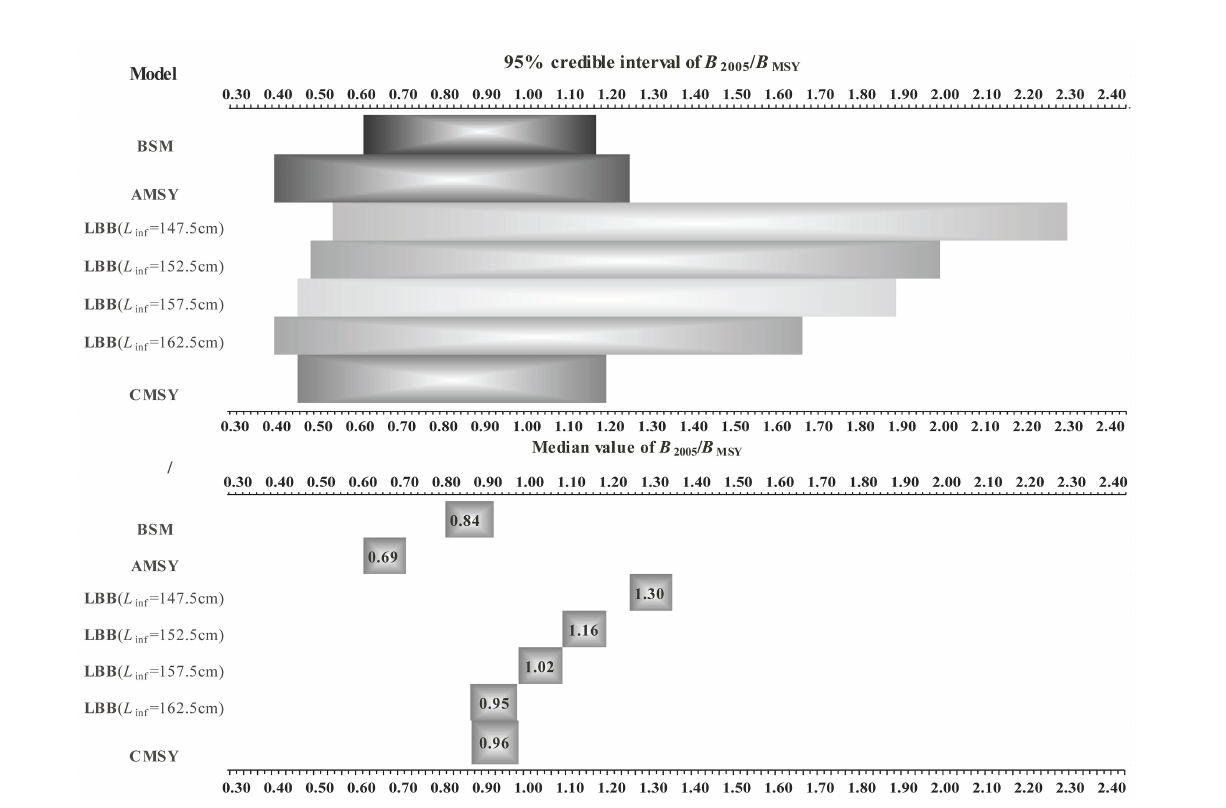
FIGURE 5 | Comparison of the estimated median values, 95% credible intervals of B 2005 / B MSY by the four models used in this